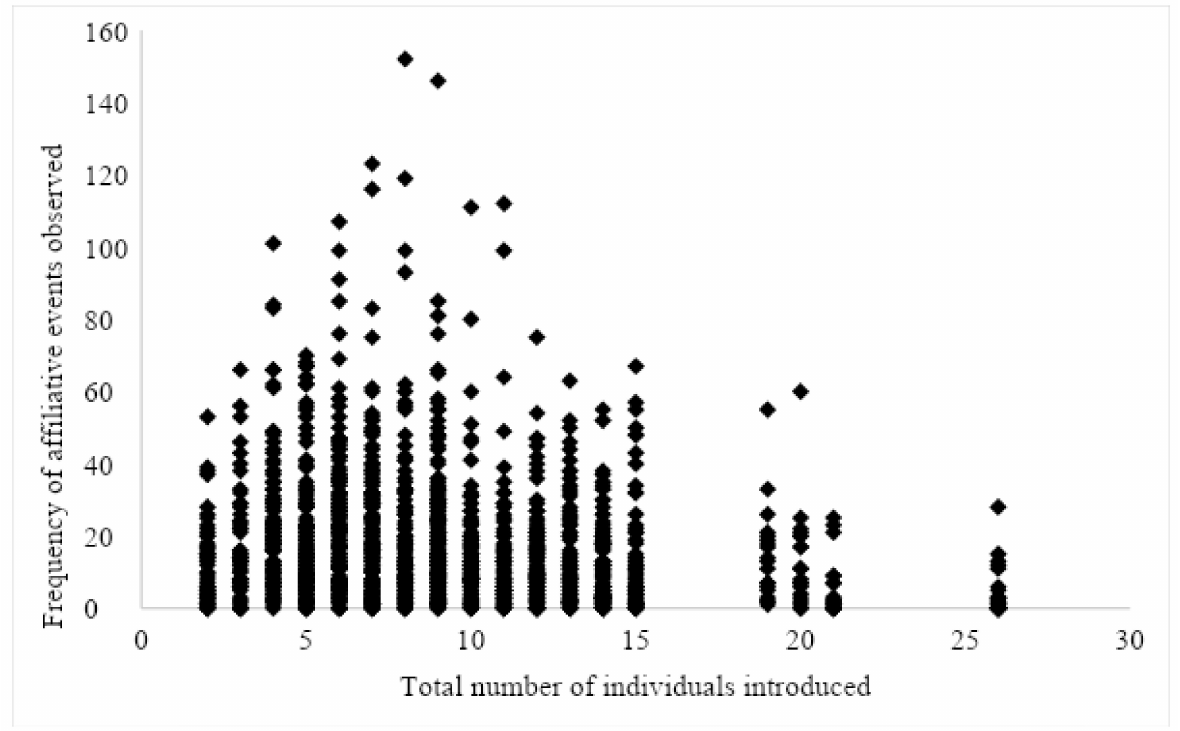
Figure 7. Scatterplot with frequency of affiliative events related to group size or total number of individuals introduced during a social